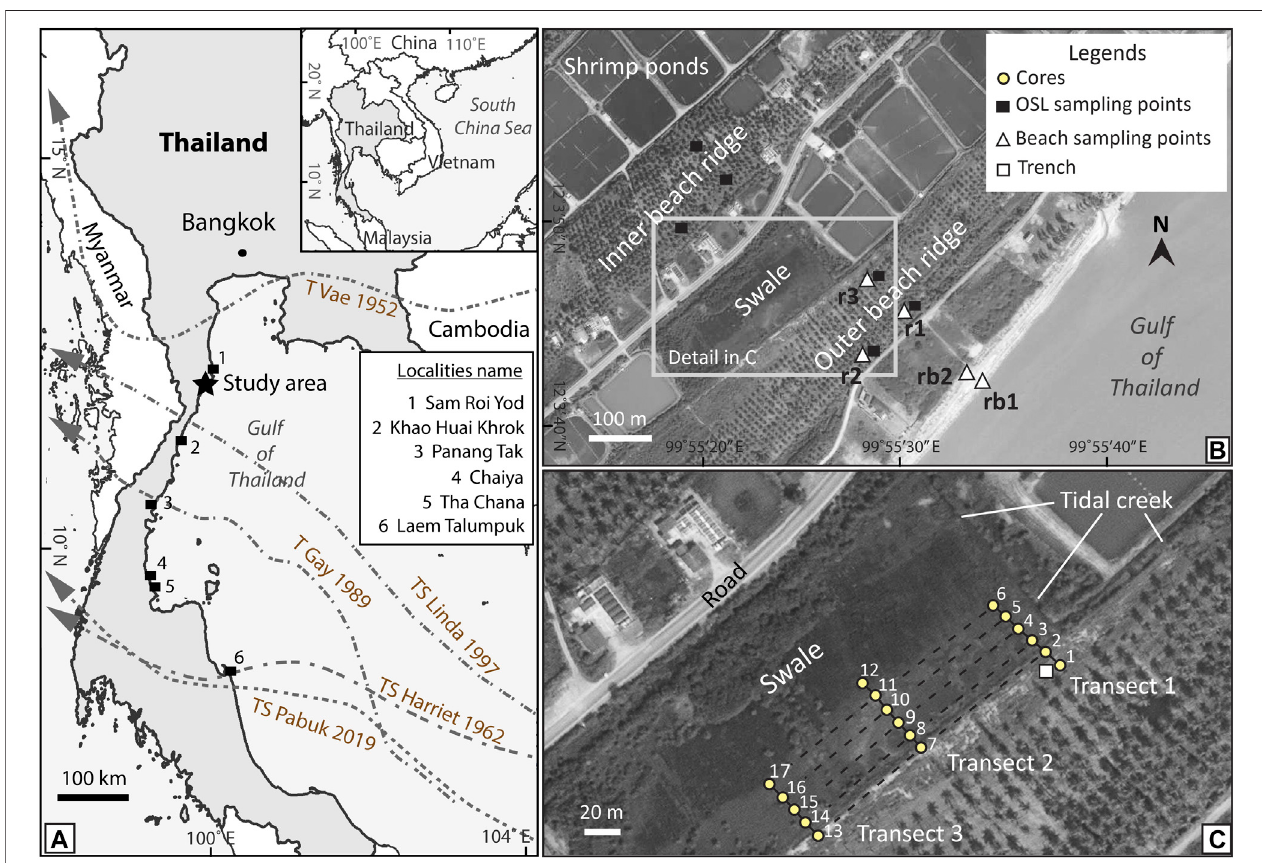
FIGURE1| LocationofthestudysiteatKuiBuri,PrachuapKhiriKhanProvince,southernpeninsularThailand. (A) ThemapshowssouthernThailandwithtracksof tropical storm (TS) and typhoon (T) striked to the coastal area, sites of documented storm deposits, and localities of historical sea-level change mentioned. (B) Orthophotograph of the beach ridge and swale, with (C) a close up of the swale and recent beach sediment showing the transect lines and sample locations.